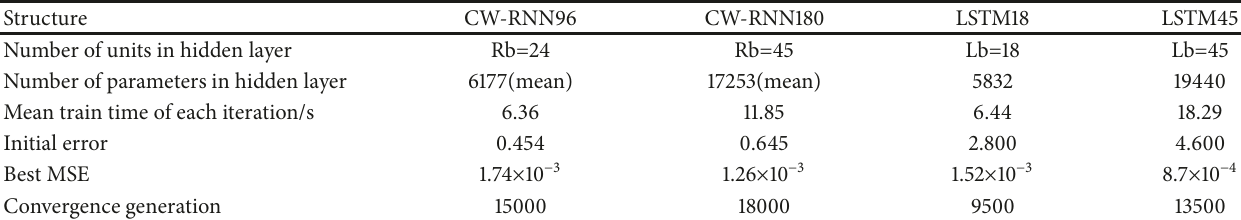
Figure 5: The mean squared error of all structures on test set. Table 1: The performance of all structures in training.